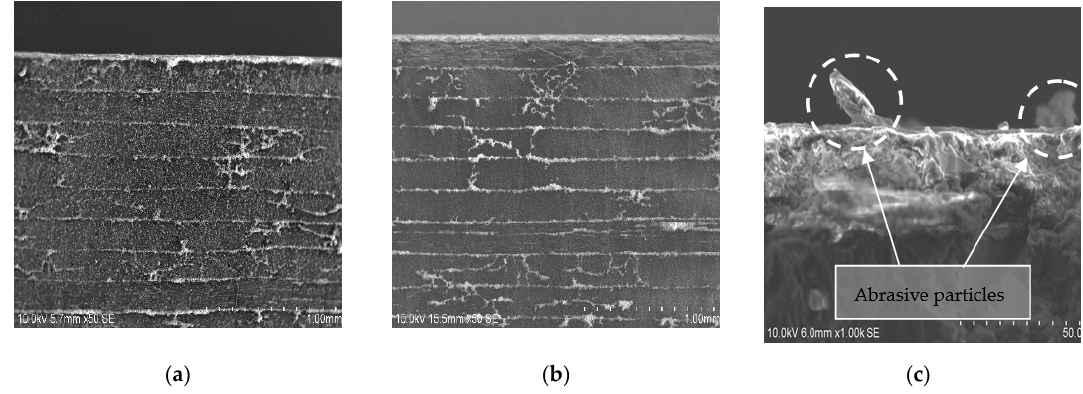
Figure 6. SOM image of CFRP profile. Test 2. Water pressure (WP) = 2500 bar, traverse feed rating (TFR) = 15 mm/min and abrasive mass flow rate (AMFR) = 340 gr/min for: ( a ) UNS A97075/CFRP; ( b ) CFRP/UNS A97075.